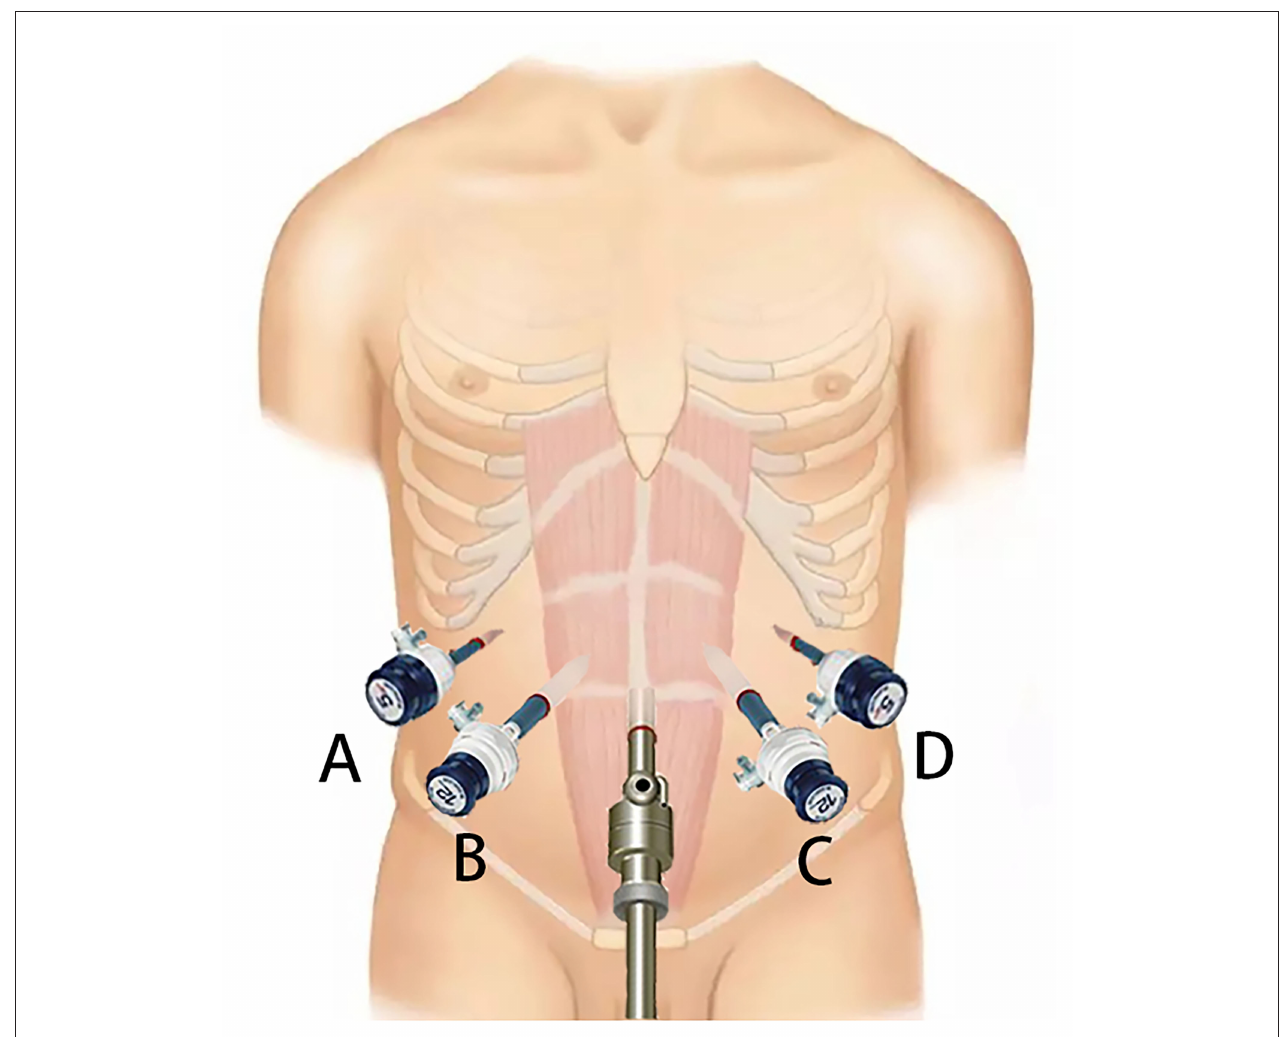
FIGURE 1 | Placement of the trocars for Laparoscopic pancreaticoduodenectomy.